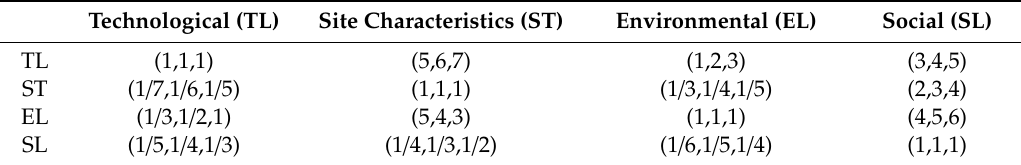
Figure 8. Main criteria and sub-criteria in Fuzzy Analytical Network Process (FANP) model. Fuzzy comparison matrix of EC from the FANP model is shown in Table 7. Table 7. Fuzzy comparison matrices for Economic factor